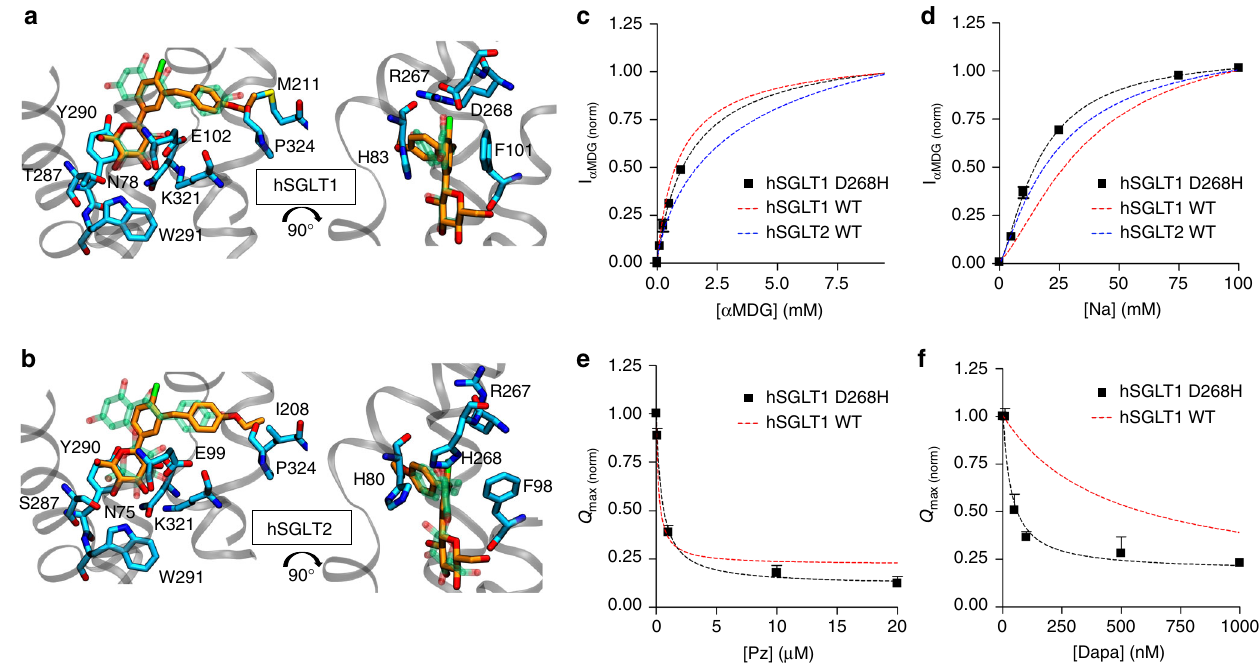
Fig. 2 Predicted binding mode of dapagli fl ozin to hSGLT1 and hSGLT2. Dapagli fl ozin (orange/red) adopts a similar pose to phlorizin (transparent green/ red) in both hSGLT1 ( a ) and hSGLT2 ( b ). Interactions in the sugar binding site and extracellular vestibule are preserved including the electrostatic interaction with R267 (hSGLT1) and the aromatic cage formed by H80, F98, and H268 (hSGLT2). c α MDG hSGLT1 D268H (black squares) sugar currents. α MDG currents were measured at V = − 50mV. The red dashed curve is a representative, wild-type hSGLT1 response. For the D268H mutant K = 1.2 ± m 0.5 0.1 mM, while wild-type hSGLT1 K 0.5 = 0.9 ± 0.1 mM. For c and d , data are normalized to the current measured at 10 mM α MDG. d Na + dependence of α MDG currents measured in 10 mM α MDG at V = − 50mV. For hSGLT1 D268H K = 17 ± 1.2 mM and for wild-type hSGLT1 K = 36 ± 1 mM. Hill m 0.5 0.5